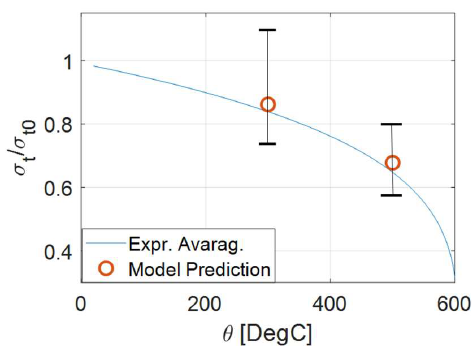
Figure 8. Predicted tensile strengths (normalized with the room temperature values) at different temperatures (the curve for the averaged measurements and the variation bars at 300 ◦ C and 500 ◦ C for different granites is reproduced after the data in [11]).